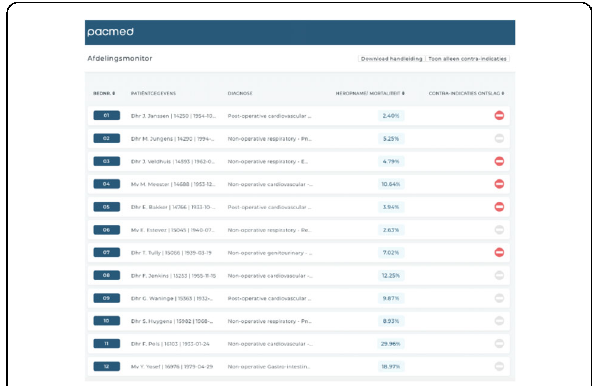
Fig. 1 (abstract 001497). See text for